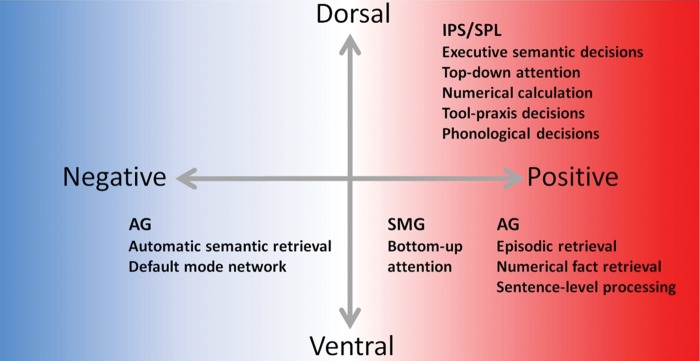
A schematic depiction summarizing the variation in polarity of activation (with respect to rest/fixation) across tasks and neural regions. Tasks associated with IPS/SPL and SMG generate (positive) activations. There is, however, considerable variation within AG ranging from deactivation (DMN and automatic semantic retrieval tasks) through to activation (for the remaining tasks)— see main text for details.